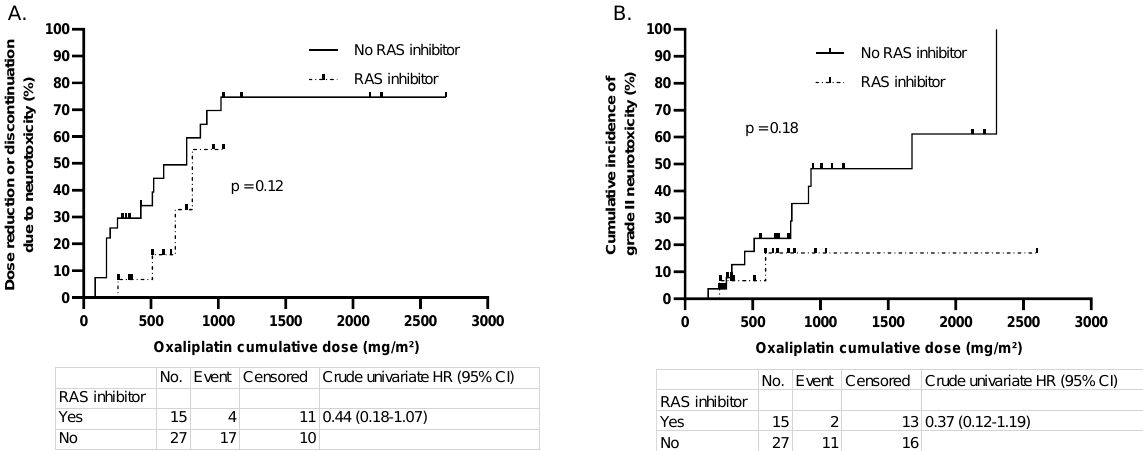
Figure 2. Kaplan–Meier curves and univariate Cox proportional hazard analysis, comparing the cumulative dose of oxaliplatin with the composite criterion of neurotoxicity ( A ) and grade 2 NCI-CTC 4.0 peripheral neuropathy ( B ). Patients who did not develop the endpoint after the completion of chemotherapy were plotted on the curves. The p -values were calculated using the log-rank test. CI: confidence interval; HR: hazard ratio; RAS: renin-angiotensin system.